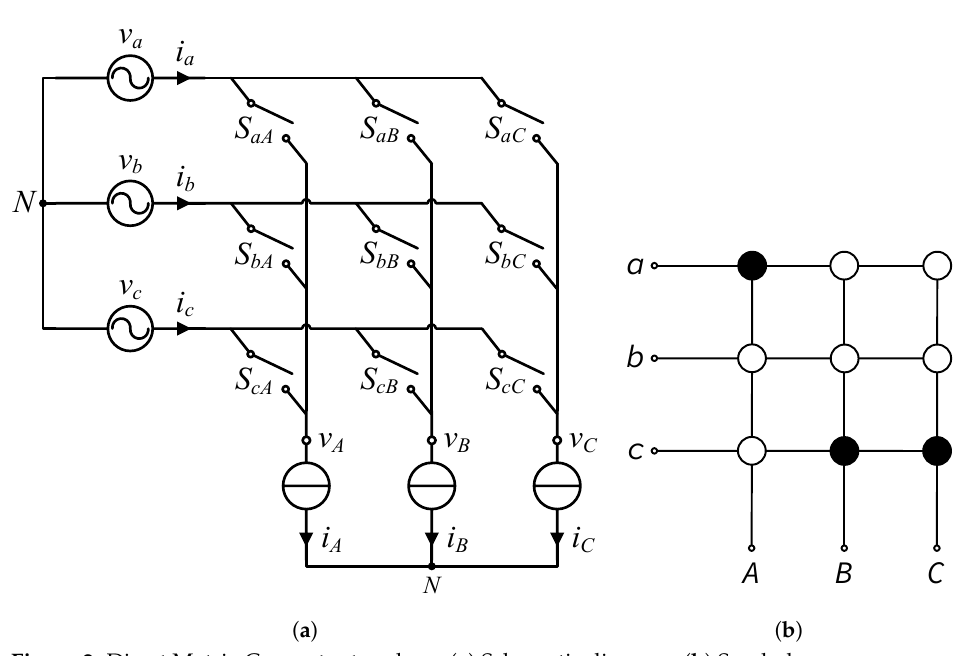
Figure 2. Direct Matrix Converter topology. ( a ) Schematic diagram. ( b )